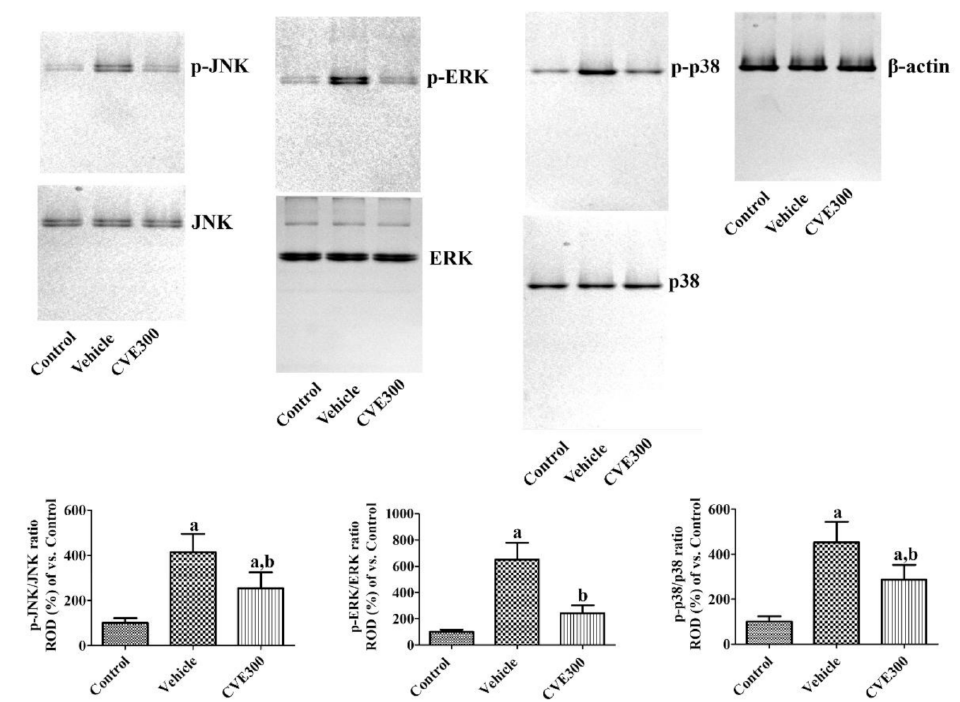
Figure 5. Cissus verticillata extract (CVE) ameliorates ischemia-induced phosphorylation of MAPKs. One day after ischemia, phosphorylation of MAPKs was assessed in the hippocampus of control, vehicle, and CVE300 groups by western blot for p-JNK, JNK, p-ERK, ERK, p-p38, and p38. Data are presented as mean value ± standard deviation and were analyzed using one-way ANOVA followed by Bonferroni’s post hoc test ( a p < 0.05, significantly different from the control group; b p < 0.05, significantly different from the vehicle